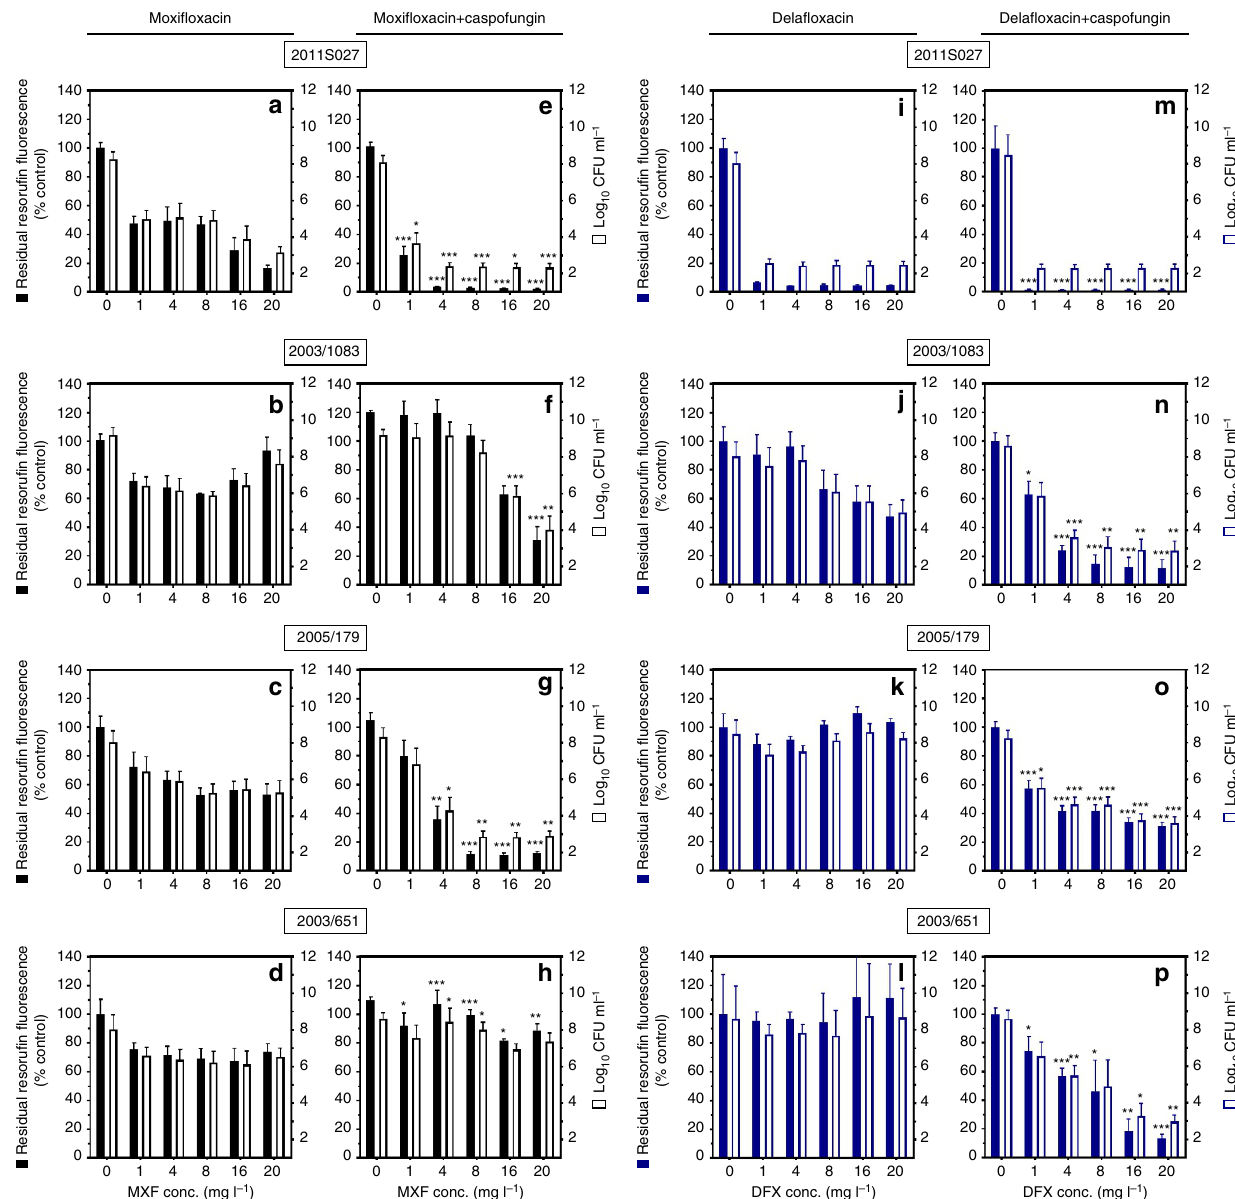
Figure 1 | Effect of fluoroquinolones alone or combined with caspofungin on biofilms from four selected strains. Biofilms were incubated during 48h in the absence or in the presence of the drugs (moxifloxacin ( a – h black) or delafloxacin ( i – p blue) at increasing concentrations and used alone ( a – d and i – l ) or combined ( e – h and m – p ) with 40mgl (cid:2) 1 caspofungin). The ordinate shows resorufin fluorescence (closed bars; left scale; expressed in percentage of the value measured in control conditions (no fluoroquinolone added)) and CFU (open bars; right scale; expressed in log 10 units). Data are the mean ± s.d. of four replicates. Statistical analysis: multiple t -tests comparing data for fluoroquinolone alone or combined with caspofungin in the same conditions: *** P o 0.001; ** P o 0.01; * P o 0.05. NATURE COMMUNICATIONS|7:13286|DOI: